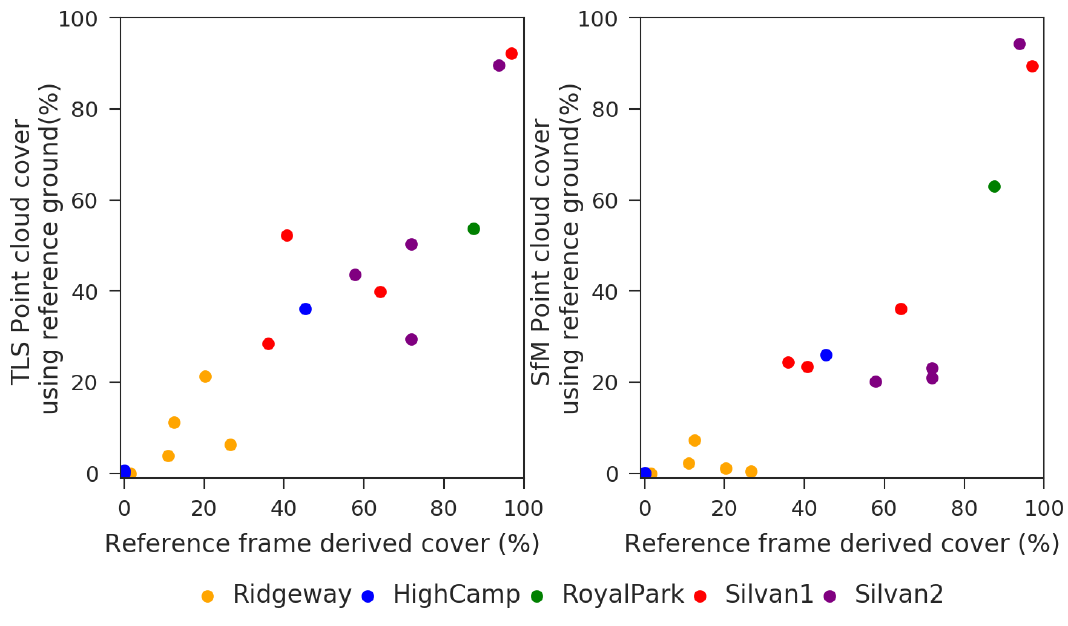
Figure 9. TLS ( a ); and SfM ( b ) point cloud cover derived using reference ground measurements compared to cover derived from reference frame